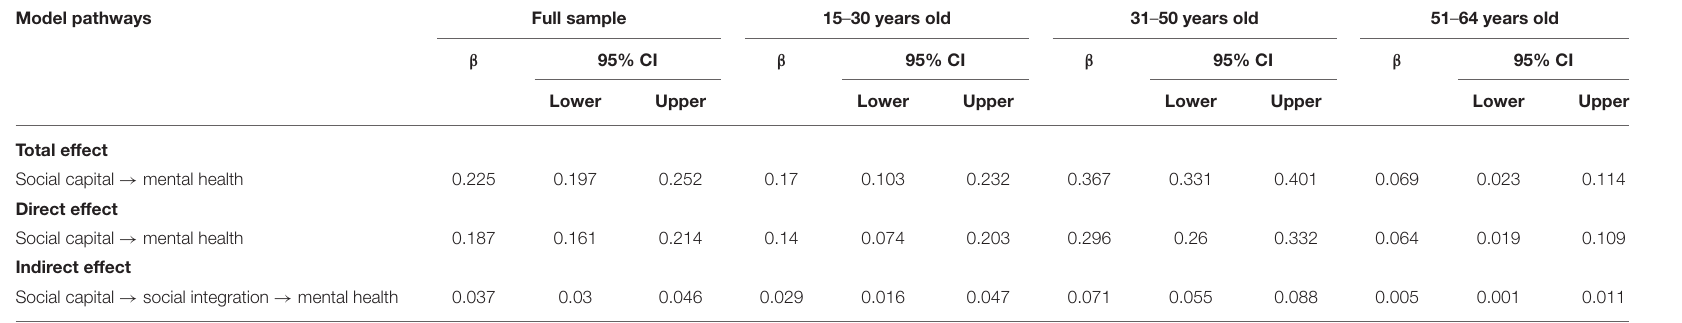
TABLE 4 | Direct and indirect effects and 95% confidence intervals